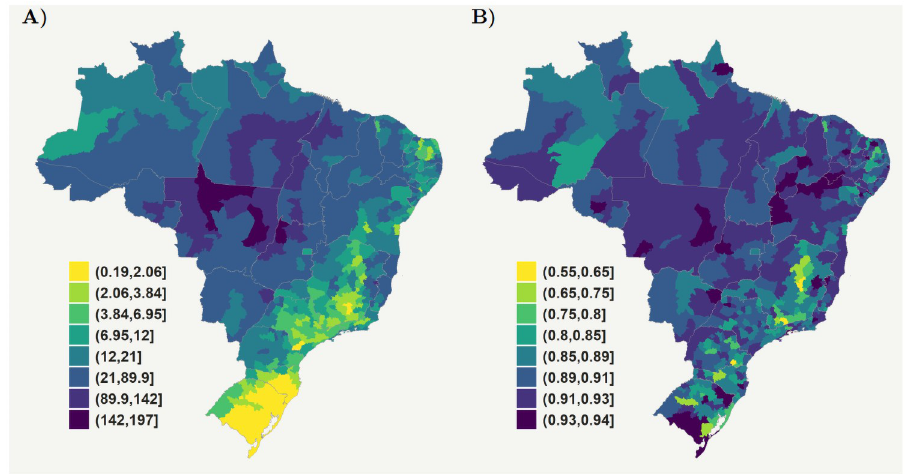
Fig 2. Brazilian microregions: (a) Mean leprosy incidence rate per 100,000 inhabitants in the period from 2007 to 2015 corrected by underreporting; (b) Estimated probability of reporting a leprosy case in each Brazilian microregion. Similar plots at state level are presented in the S1 Fig. Raw data are shown in this figure and available at https://github.com/cidacslab/Estimating-under-reporting-of-leprosy-in-Brazil.git [31]. We produced the maps using R software, geobr package [31, 32], (MIT license https://ipeagit.github.io/geobr/).